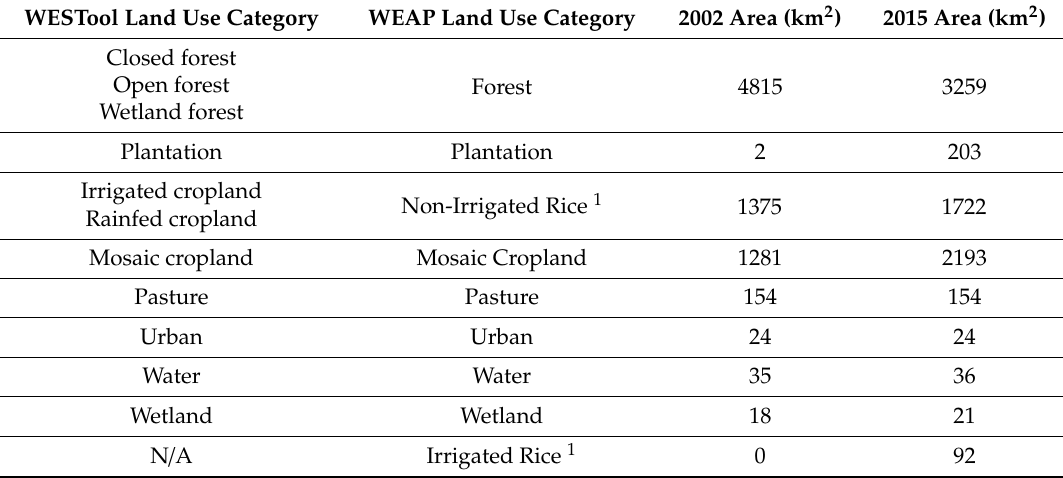
Table A2. Land use categories used in the Stung Chinit model, how they correlate with the WESTool land use categories and coverage of each land use type in 2002 and